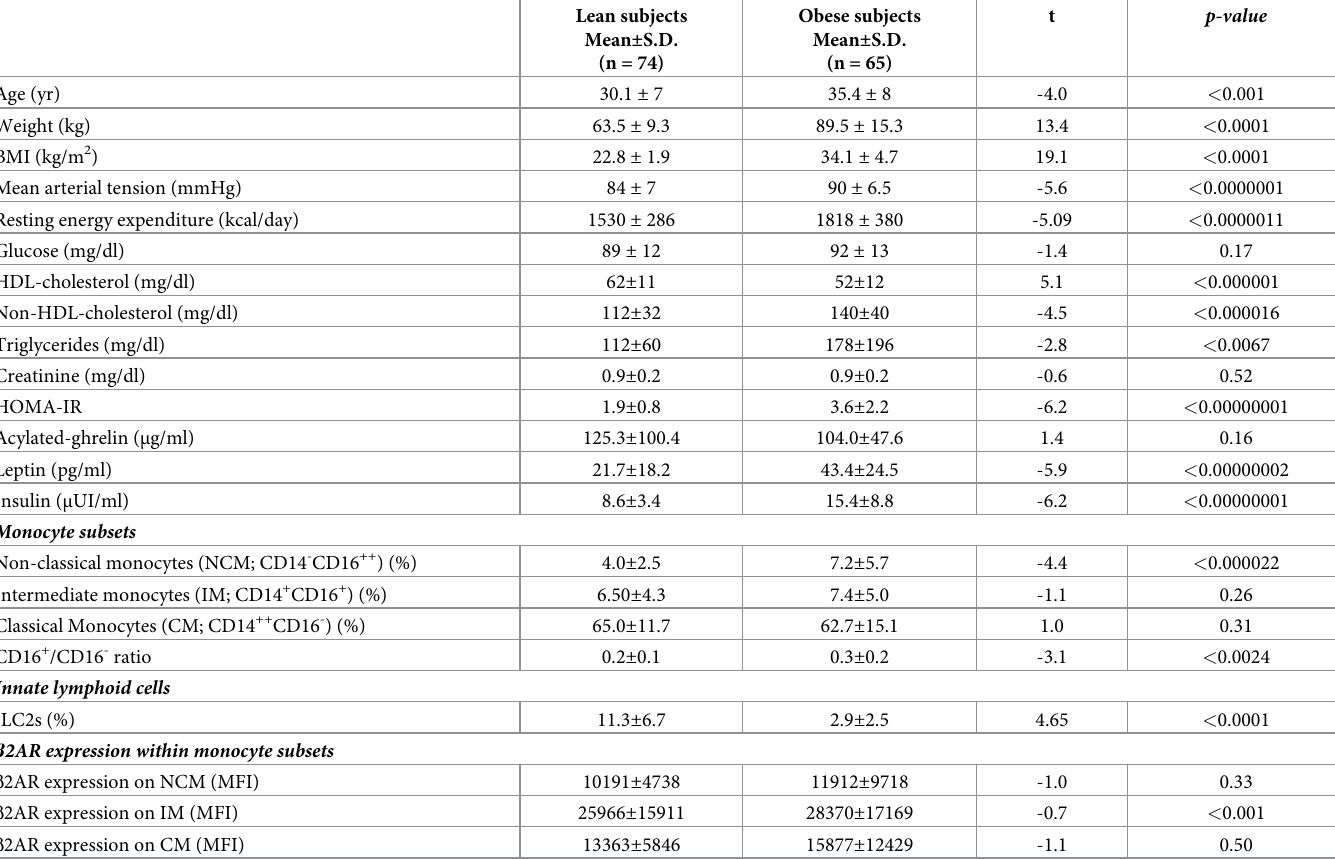
Table 1. Comparison of basal characteristics among individuals.